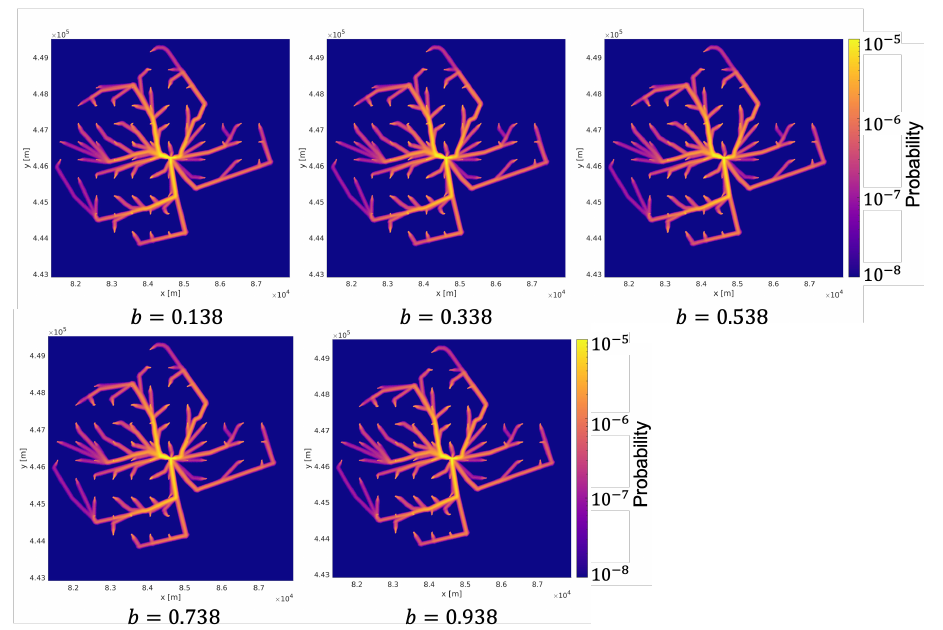
Figure A9. Annual IR with different b in fatality model. Table A1. Summary of risk assessment model parameters.